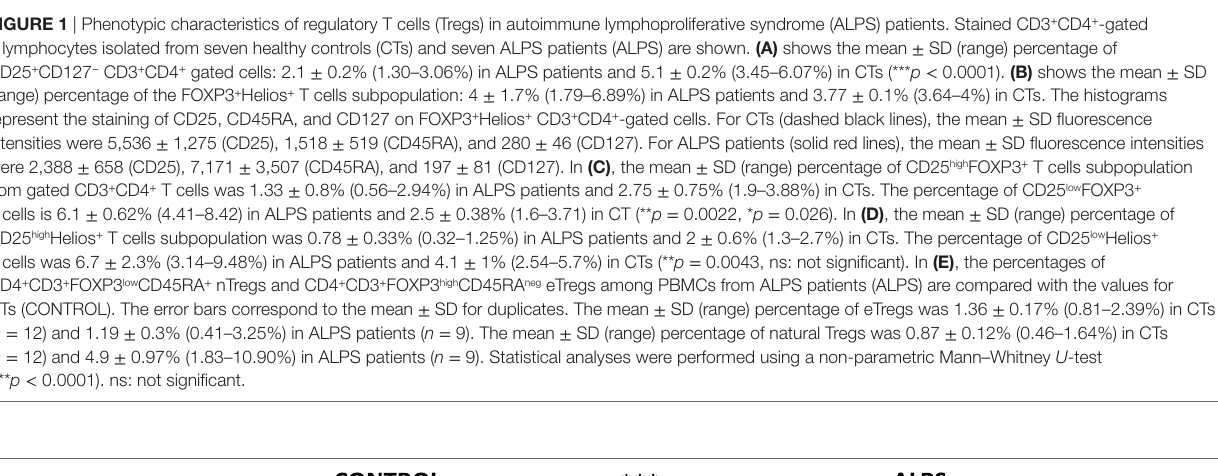
FigUre 1 | Phenotypic characteristics of regulatory T cells (Tregs) in autoimmune lymphoproliferative syndrome (ALPS) patients. Stained CD3 + CD4 + -gated T lymphocytes isolated from seven healthy controls (CTs) and seven ALPS patients (ALPS) are shown. (a) shows the mean ± SD (range) percentage of